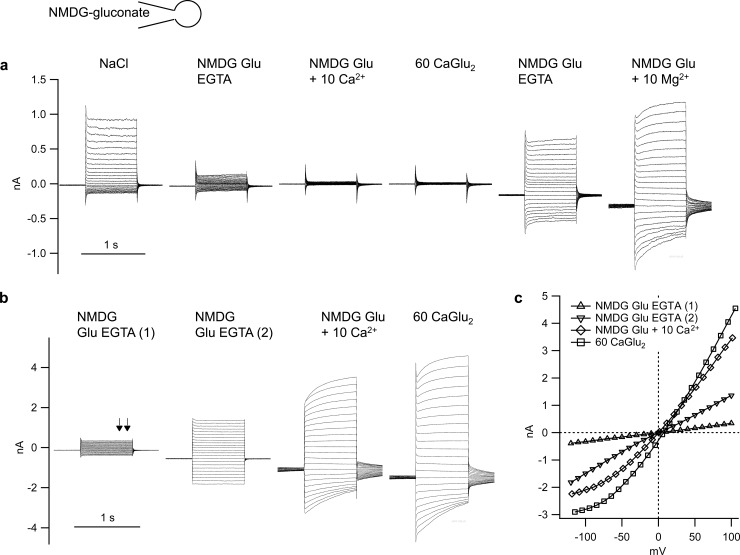
Original recordings of two bTRPV3 cells filled with NMDG-gluconate solution.a) As before, replacement of chloride by gluconate resulted in a decrease in outward current at positive potentials, suggesting expression of chloride channels. Both addition of Ca2+ (10 mmol∙l−1) and replacement by Ca-gluconate2 (60 mmol∙l−1) had a strong blocking effect, with washout to levels higher than before. The current could be partially blocked by Mg2+, arguing against a rupture of the seal. Note the current kinetics with amplitude decreasing after a hyperpolarising pulse suggesting that Mg2+ is being drawn into the channel pore by the negative membrane voltage. Conversely, a depolarising voltage pulse leads to a relief of the block. In both cases, the currents appear curved in contrast to the linear kinetics of currents in pure NMDG-gluconate solution. b) Second cell, showing a spontaneous activation of inward and outward current amplitude by a factor of about four between the first set of pulses in NMDG-gluconate EGTA solution (1) and a second set (2) that was run 100 seconds later. Current amplitude continued to increase both after addition of 10 mmol∙l−1 Ca2+ to the NMDG-gluconate solution, and after replacement of NMDG-gluconate by Ca-gluconate2. Both the current kinetics and the tail currents indicate a partial voltage-dependent block. The arrows above the first set of pulses indicate the interval used for the determination of mean current amplitude for the current-voltage plot, which is depicted in c), showing rectification as a further sign of a voltage-dependent block. The reversal potential in 60 mmol∙l−1 Ca-gluconate2 solution was 7.1 mV, revealing permeability to Ca2+.